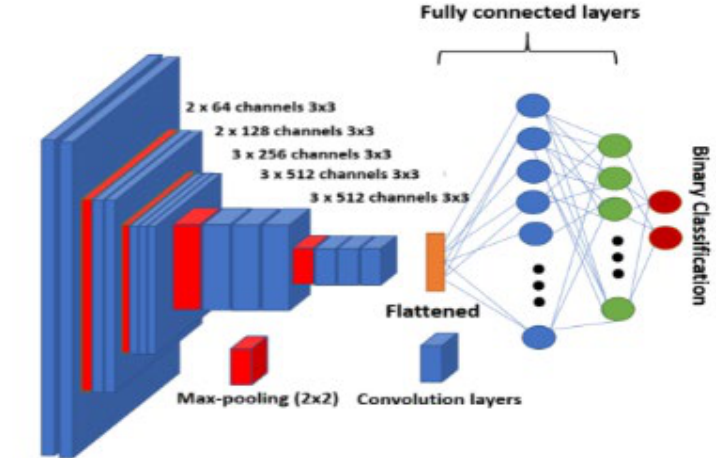
Figure 3. VGG-16 CNN framework.